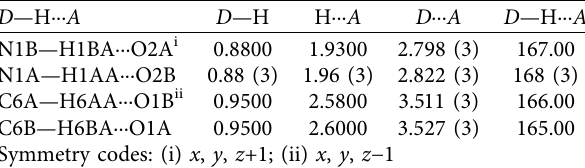
Table 4: Hydrogen-bond geometry of the crystal structure 11 (˚A, ° ).